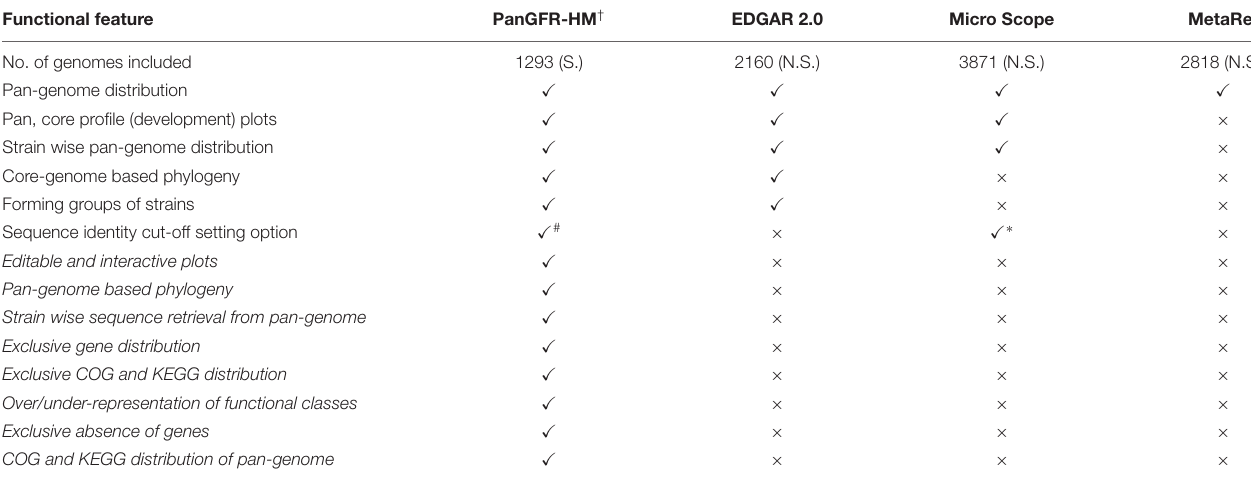
TABLE 2 | Comparison of PanGFR-HM with other microbial pan-genome analysis resources. Functional